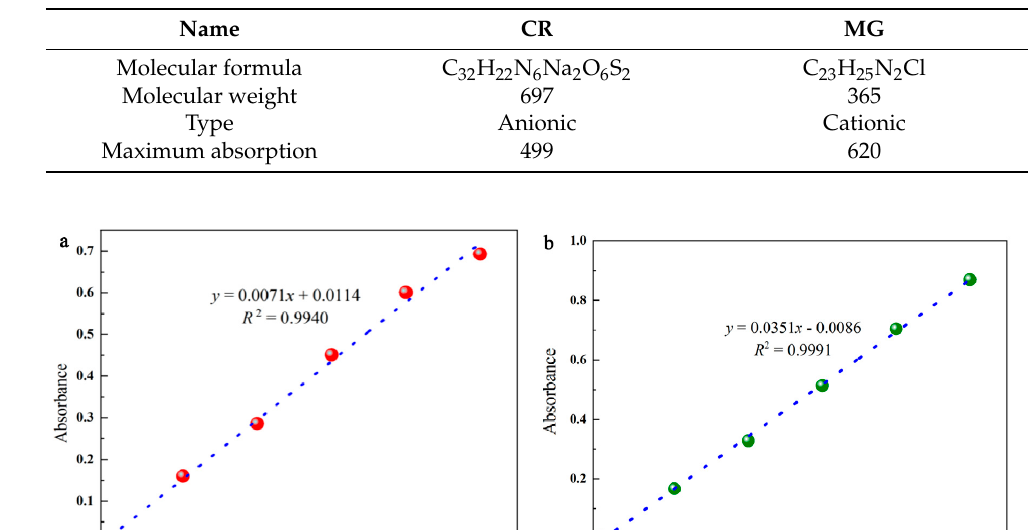
Table 5. Basic parameters of the two organic dyes.